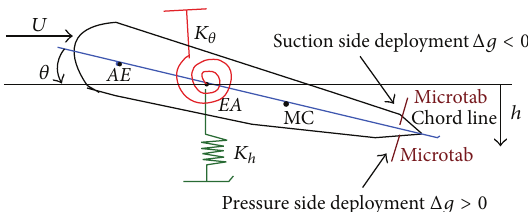
Figure 1: Model of the blade section with trailing-edge